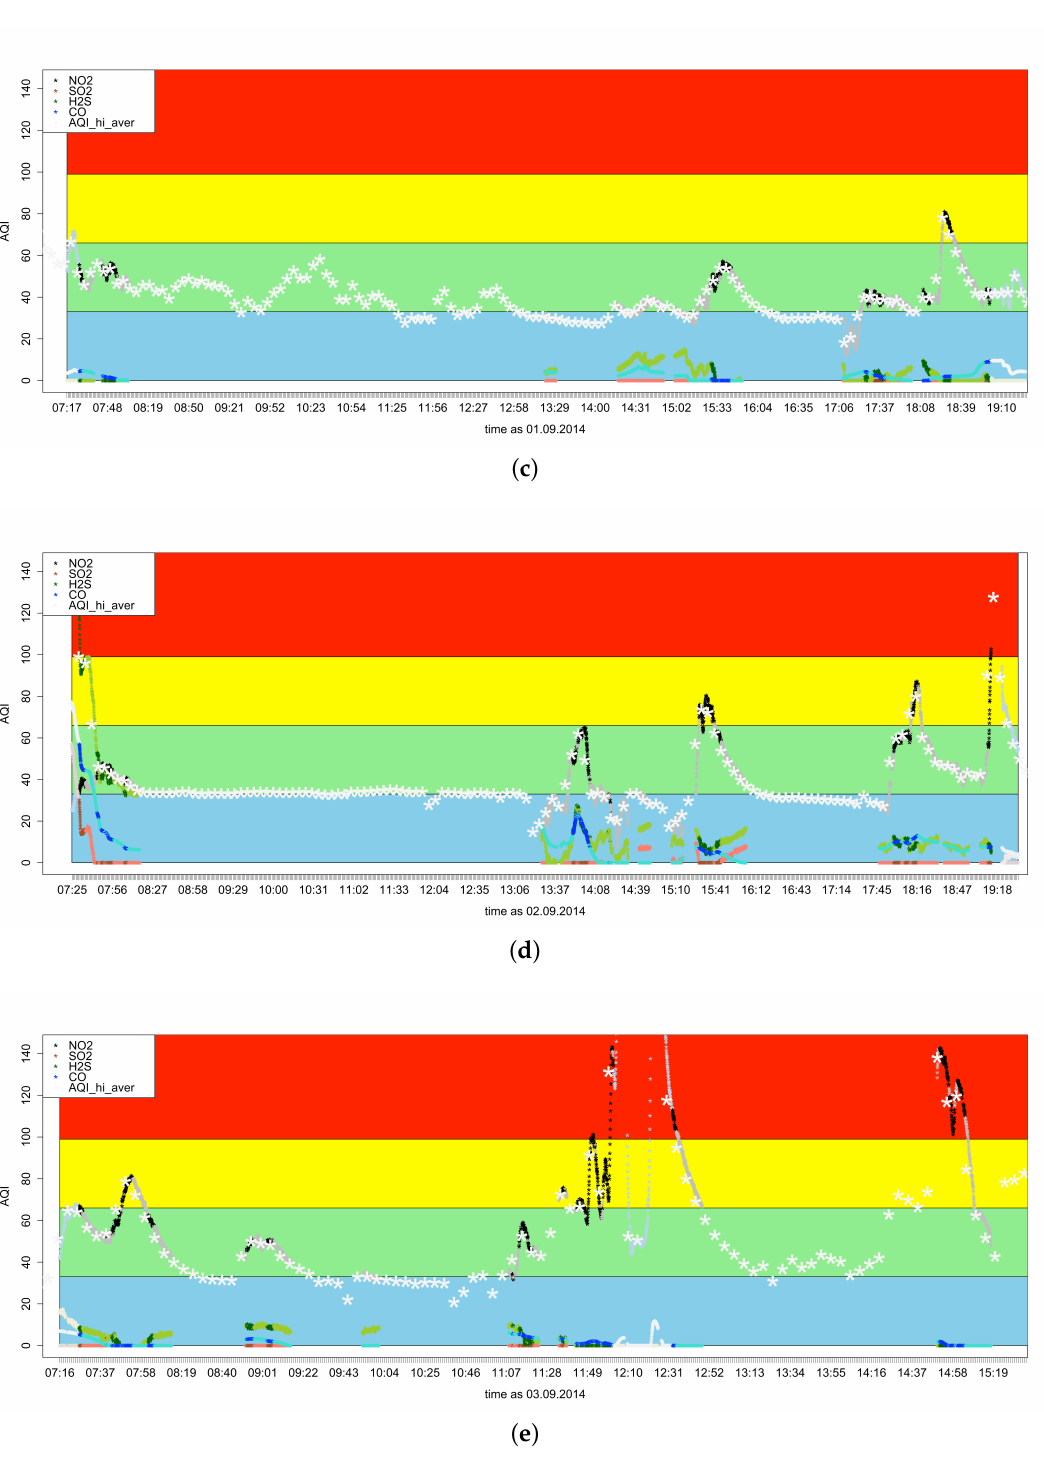
Figure 7. AQIs’ time series during the campaign. The different components are represented in the legend by various colors (black for AQI NO , brown for AQI SO , green for AQI H and blue for AQI CO ). 2 2 2 S For each component, three color shades are associated: full color when the SmartBus was on the Smart Ring and in motion; a lighter color when the SmartBus was along the Smart Ring, but at rest; the lightest colors relate to the SmartBus position outside the Smart Ring when the bus was in motion. The white-colored stars show the 5-min averaged AQI hi . Background areas are colored according to the AQI classification in Table 4. ( a ) AQIs time series for 28 August 2014; ( b ) AQIs time series for 29 August 2014; ( c ) AQIs time series for 1 September 2014; ( d ) AQIs time series for 2 September 2014; ( e ) AQIs time series for 3 September